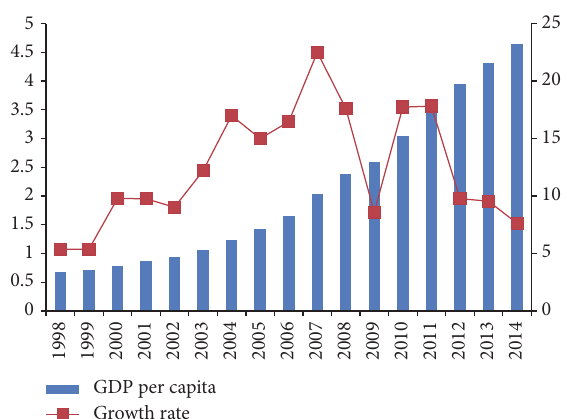
Figure 2: GDP per capita in China from 1998 to 2014 (ten thousand yuan) and the growth rate (%).